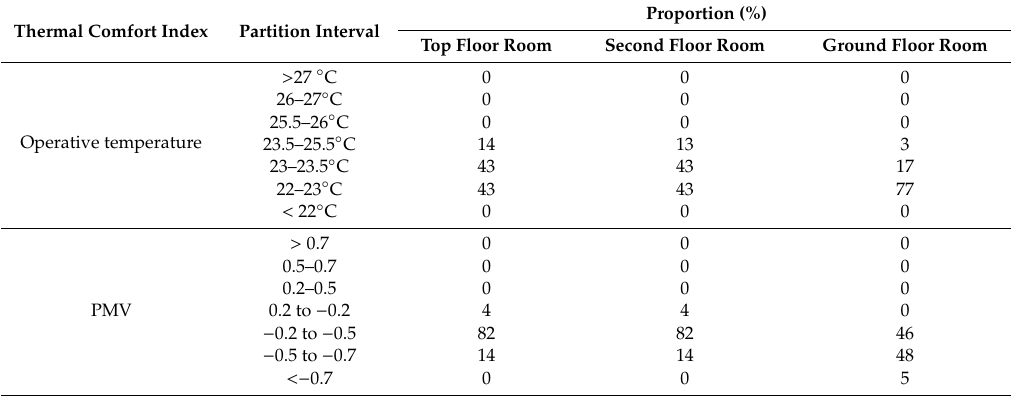
Table 5. Proportions of time at which di ff erent operating temperature and PMV intervals occur during the whole cooling period under the scheme using Equation